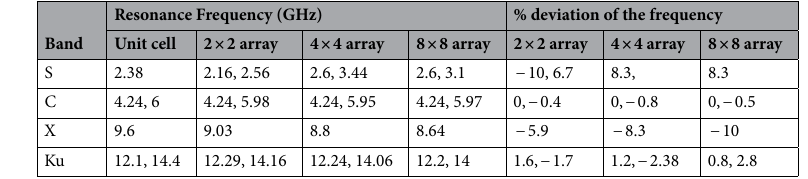
Table 5. S 21 comparison between array and unit cell. A minus sign in % deviation indicates shifts of resonance towards lower frequency, whereas positive deviation indicates a shift towards higher.